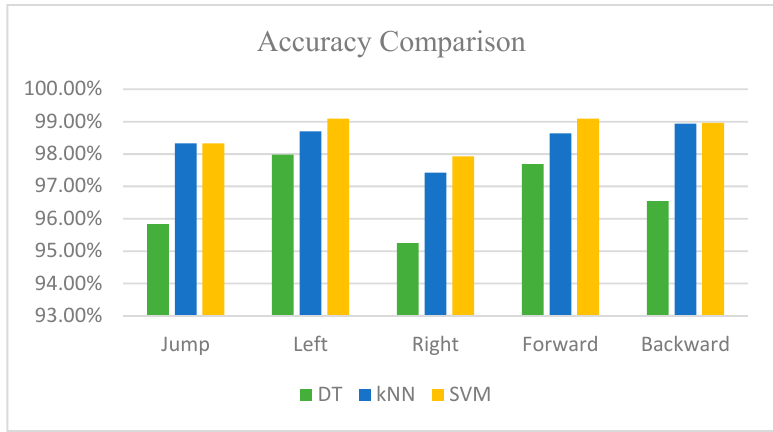
Figure 12. Accuracy comparison of three classifiers.